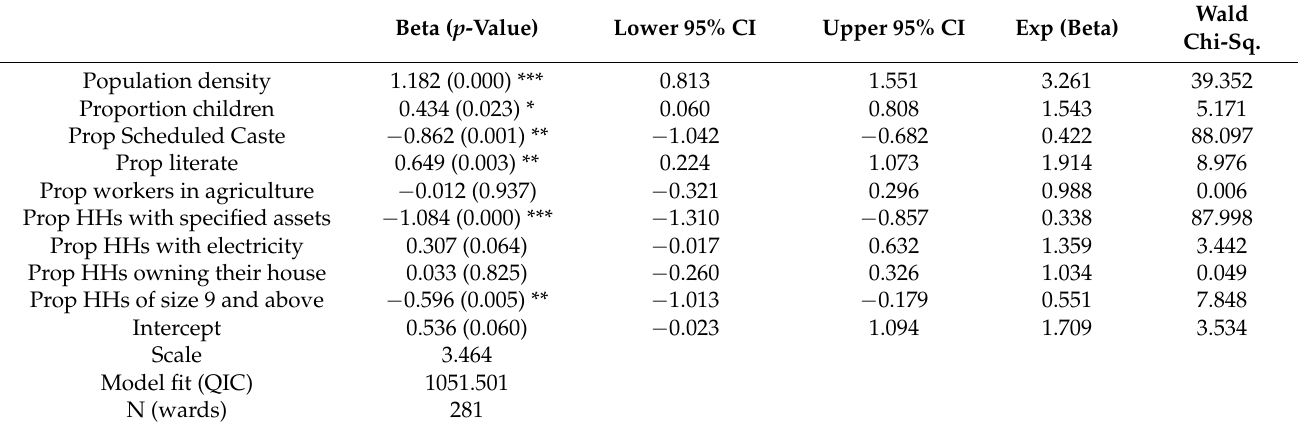
Table 3. Generalized estimating equation for predicting September UHRI using ward level socio-demographic